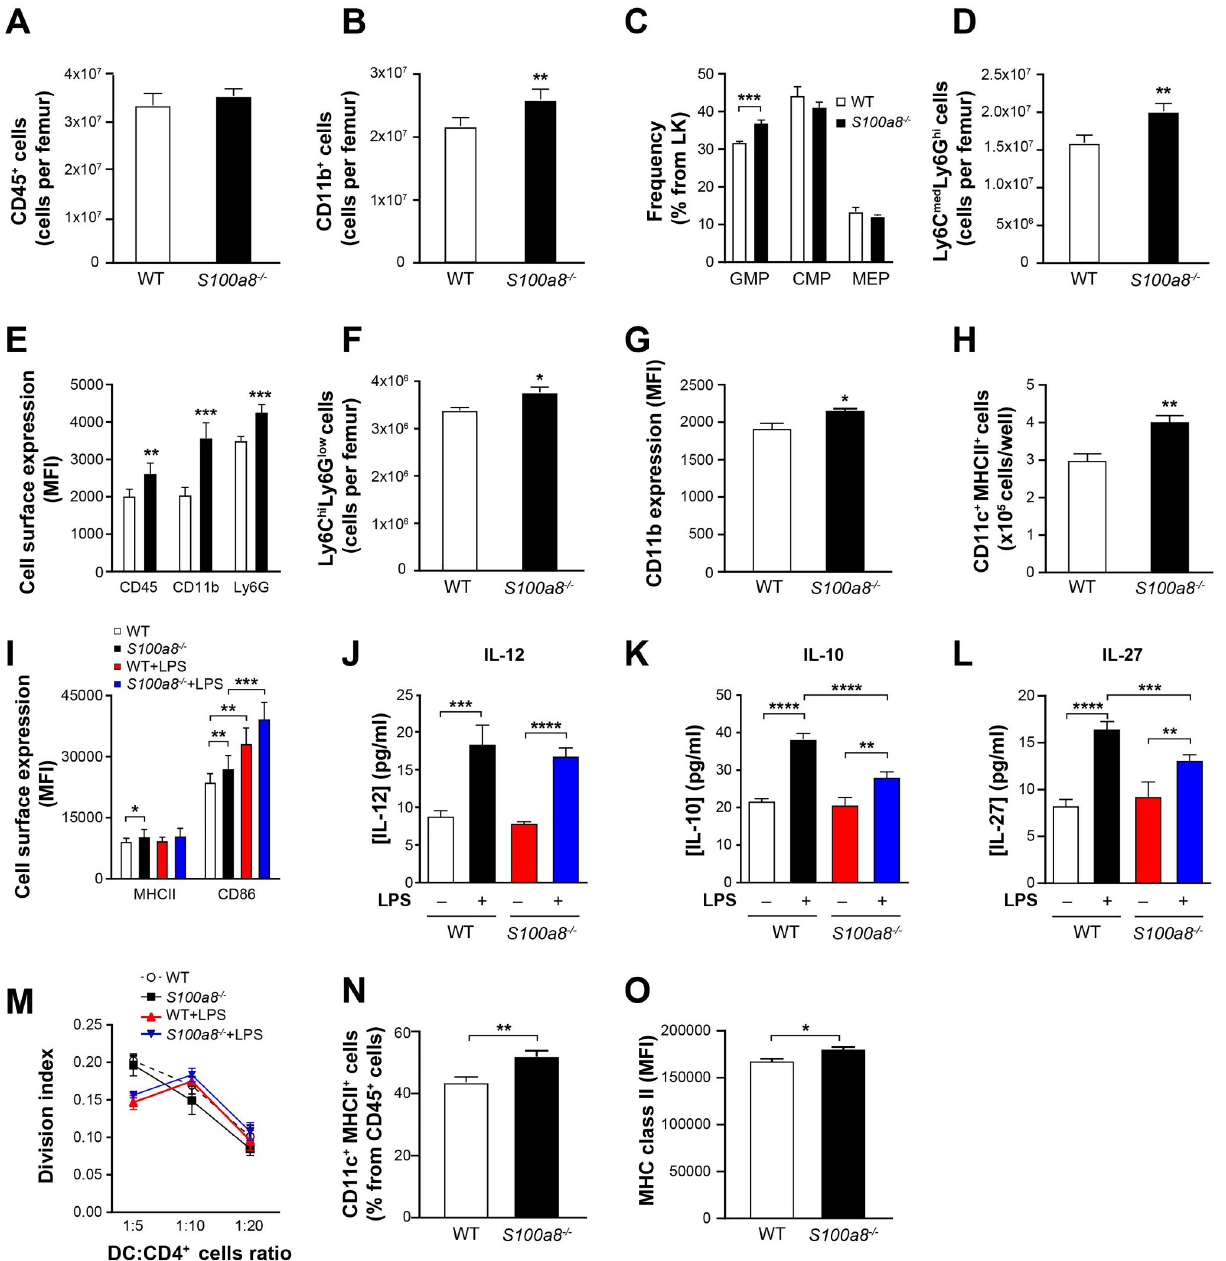
Fig 3. Increased numbers of dendritic cells in S100a8 -/- mice. (Values in A–I are from flow cytometry, based on 4 mice in A–G and on 12 mice in H and I. WT = wild type.) (A) CD45+ cells in bone marrow. (B) CD11b + myeloid cells in bone marrow. (C) Frequency of granulocyte-macrophage progenitors (GMP), common monocyte progenitors (CMP) and megakaryocyte-erythrocyte progenitors (MEP) in bone marrow. (D) Neutrophil- committed (Ly6C med Ly6G hi ) cells in bone marrow. (E) Expression of CD45, CD11b and Ly6G on the surface of neutrophil-committed cells. (F) Monocyte-committed (Ly6C hi Ly6G low ) cells in bone marrow (G) Expression of CD11b on the surface of monocyte-committed cells. (H) Bone-marrow- derived dendritic cells (CD11c + MHC class II + ) cultured with GM-CSF and IL-4. (I) Expression of MHC class II (MHCII) and CD86 on the surface of dendritic cells. (J–L) Secretion of IL-12, IL-10 and IL-27 by dendritic cells stimulated with 100 ng/mL LPS (4 mice). (M) Dendritic-cell-induced proliferation (mixed lymphocyte reaction) of CD4 + T cells obtained from B10 mice versus DC/CD4 + T ratio (3 mice). (N) Dendritic cell crawl-out from the skin (8 mice). (O) Expression of MHC class II molecules on the surface of dendritic cells crawling out of ear skin (8 mice). All values are mean ± sem. � p < 0.05; �� p < 0.01; ��� p < 0.001, Student’s t-test.